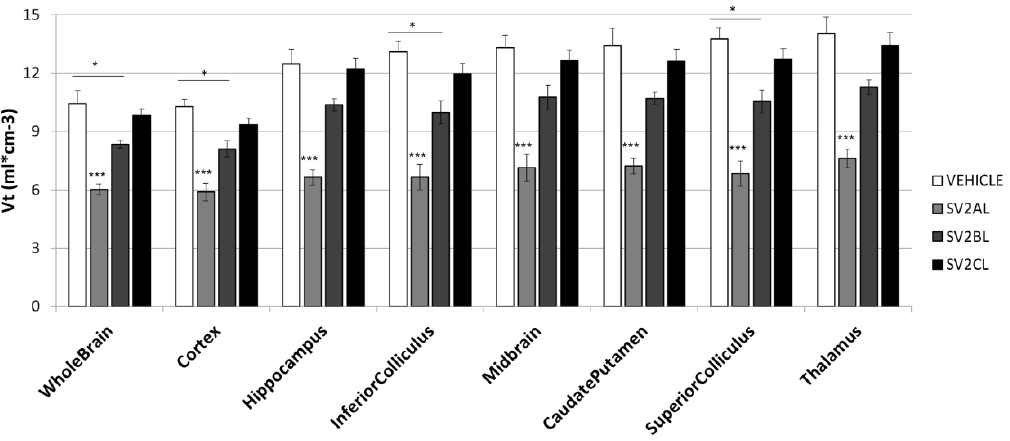
Figure 4. Vt values for the eight selected brain structures. Bars represent the mean ± SEM (n = 5). One-way ANOVA and Sche ff e post-hoc tests were performed, with *** p < 0.001 and * p < 0.05. Table 2. Illustration of the impact induced by the blocking experiments, expressed as percentage of reduction calculated from the mean Vt values (n = 5) for the eight selected